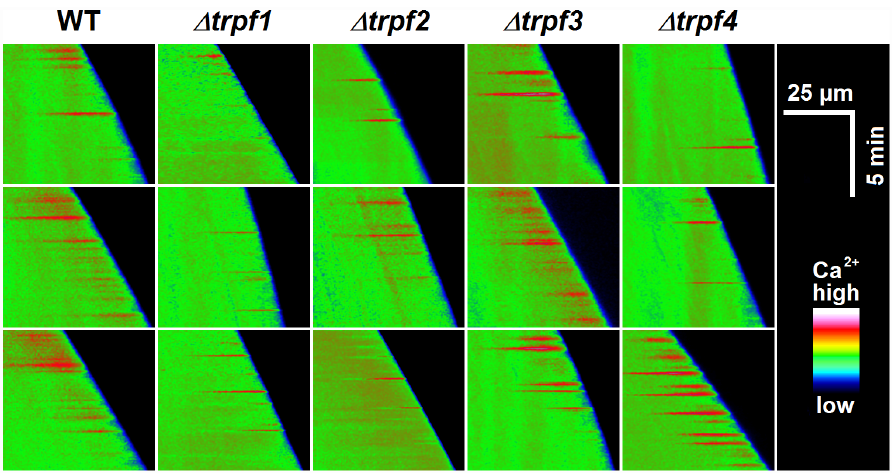
Fig 8. Yellow Cameleon-based measurements of [Ca 2+ ] cyt in individual hyphae. Kymographs of individual hyphae of wild type and deletion mutants. Each horizontal pixel line represents the mean [Ca 2+ ] cyt of a 5-pixel-wide ROI in the middle of each hypha. ROIs of subsequent images, acquired every 2 sec, were plotted one below the other. The slope of the kymographs, read from top to bottom, thus indicates the growth rate. Relative [Ca 2+ ] cyt is displayed in false-colour using the RGB rainbow scale. All measurements were performed on hyphae growing at an mLCM agar-glass interface